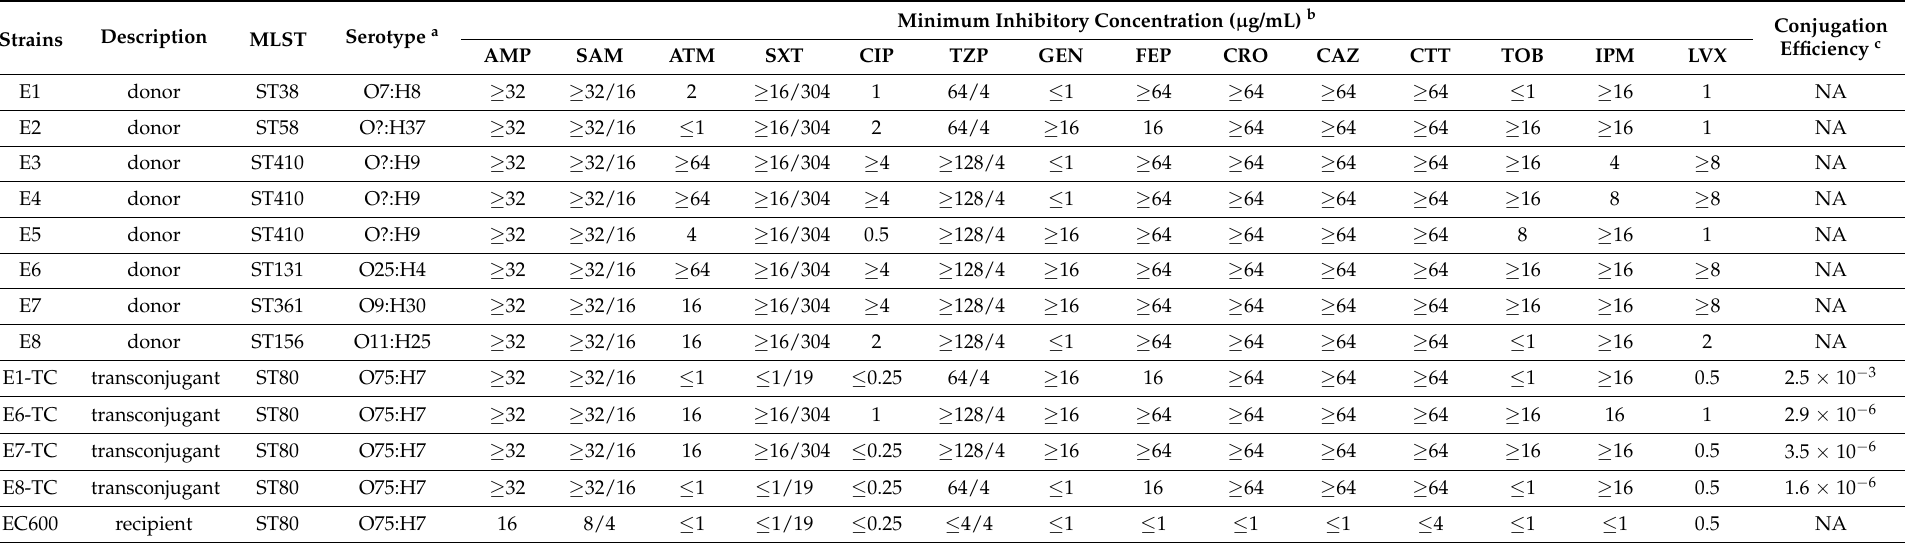
Table 2. MLST type and antibiotic resistance characteristics of Escherichia coli strains and their corresponding